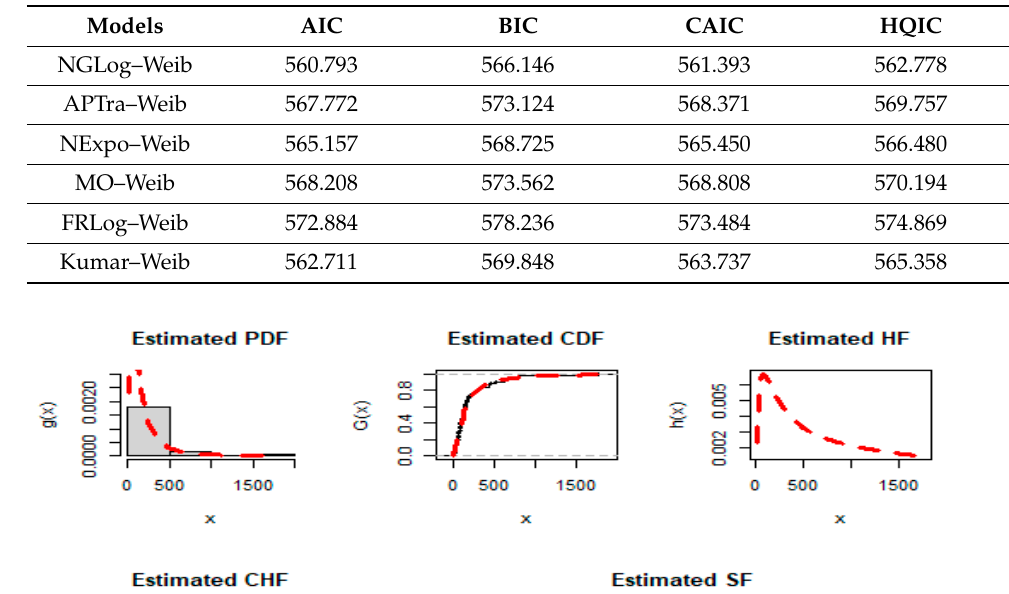
Table 11. The DMs of the competing models for head and neck cancer, dataset 2.